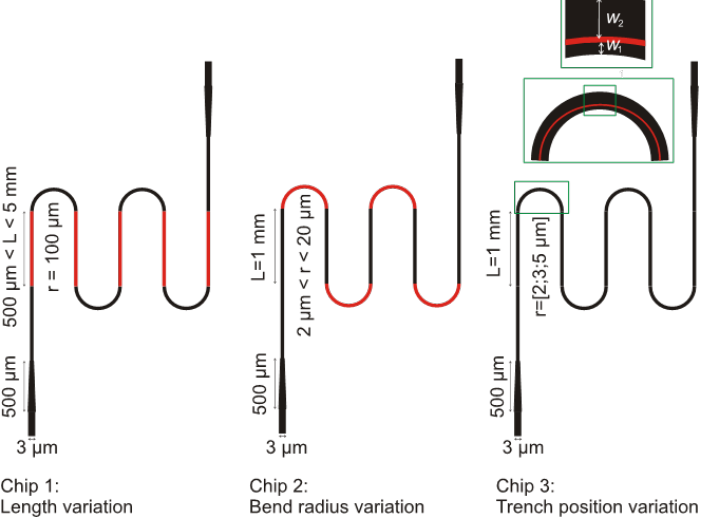
200 nm, 300 nm, 𝑊𝑊 =